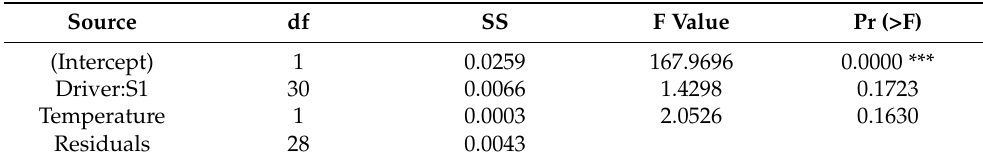
Table 5. ANOVA for regression model with driver–scenario interaction.